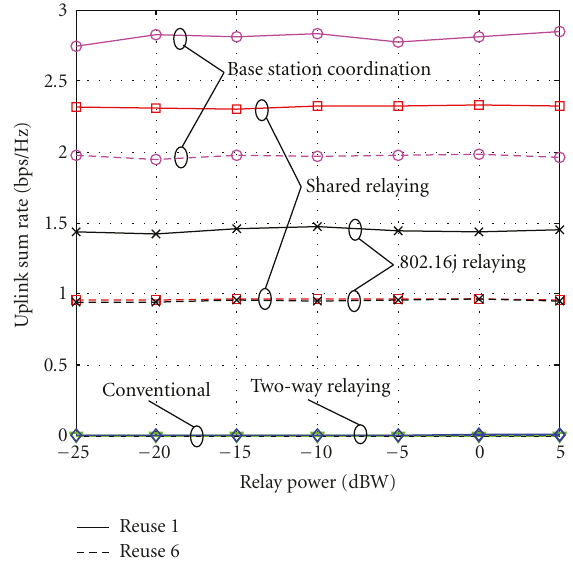
Figure 9: Uplink sum rates for each of the strategies presented in this paper as a function of the relay transmit power. The solid lines represent reuse factor 1, while the dotted lines represent reuse factor 6.